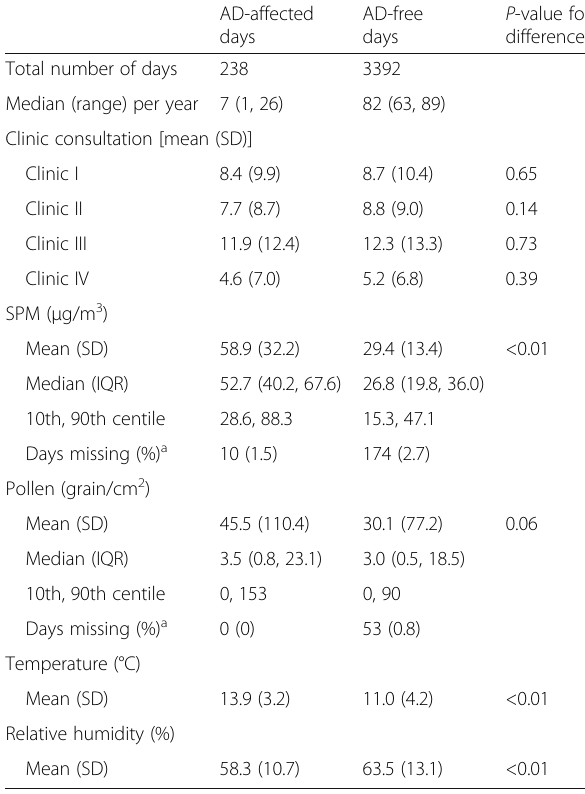
concentrations of SPM, airborne pollen and meteorological variables by the presence of AD